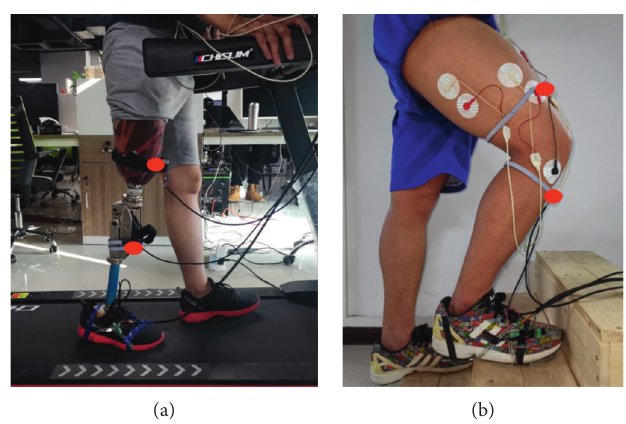
Figure 1: Experiments of different locomotion: (a) level walking; (b) stair